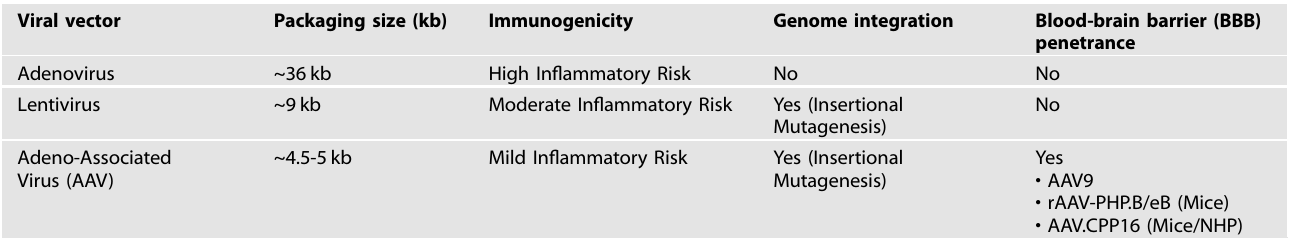
Table 1. Comparison of viral vectors discussed in the review.